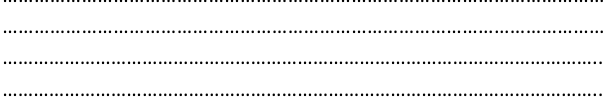
12. What other treatment(s) do you utilise?